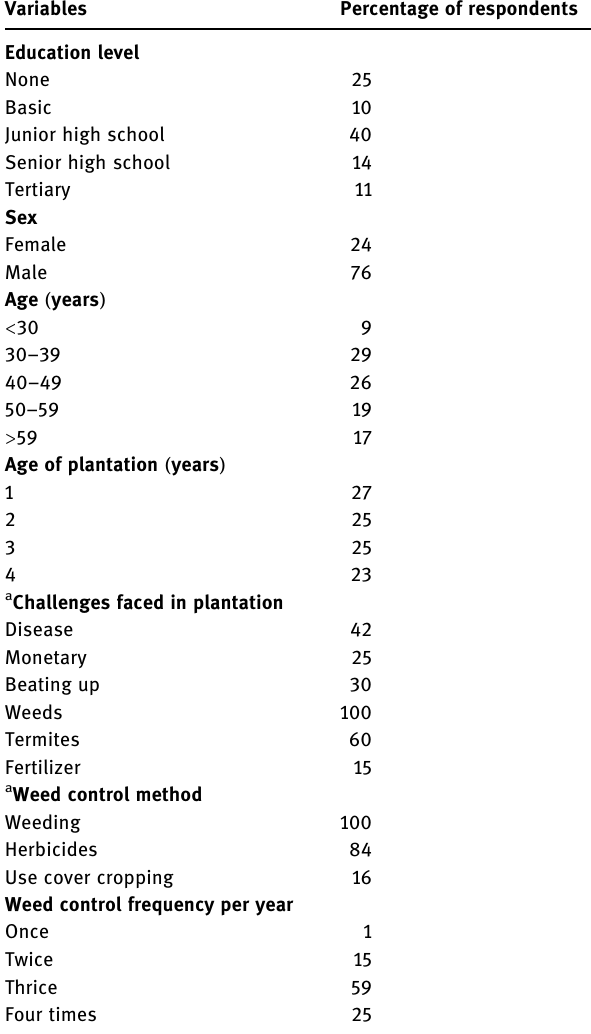
Table 2: Sociodemographic characteristics of smallholder out - growers surveyed from eight communities in the Western Region of Ghana ( n = 80 ) , the challenges they faced in their plantations, weed control method employed, and their frequency per